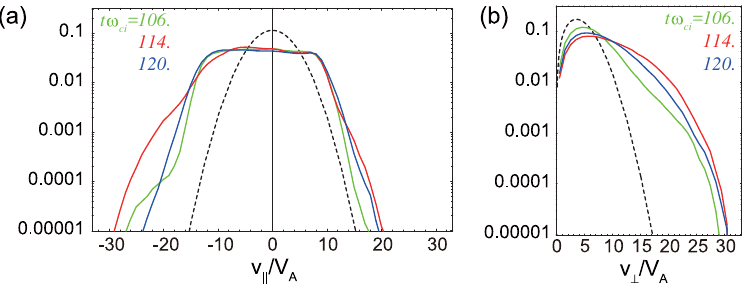
Figure 4. Reduced distribution functions of the electrons in (a) parallel and (b) perpendicular directions. The distribution functions are averaged over the field line ( − 50 ≤ l/λ i ≤ 0) traced from (x,z) = ( 0 , − 18 . 5 ) at tω ci = 106 (green curves), 114 (red curves), and 120 (blue curves). The dashed curves indicate the distribution function of the initial background (lobe)